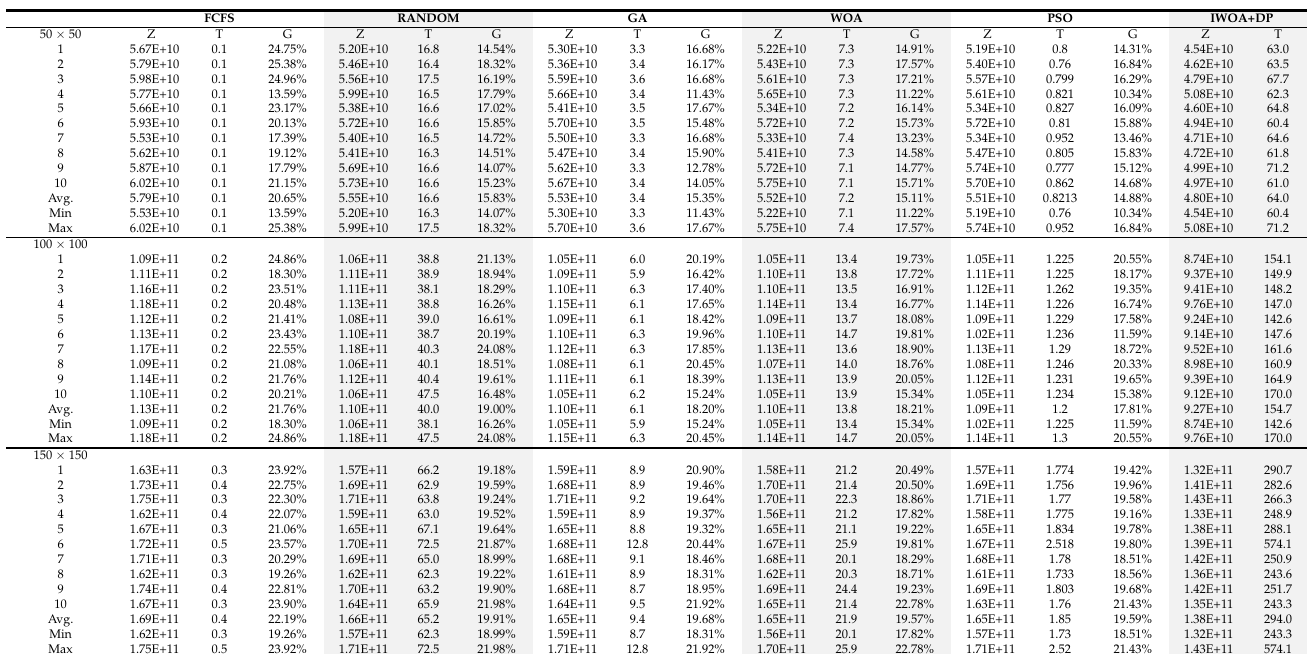
Table 5. The results obtained from different approaches using different problem